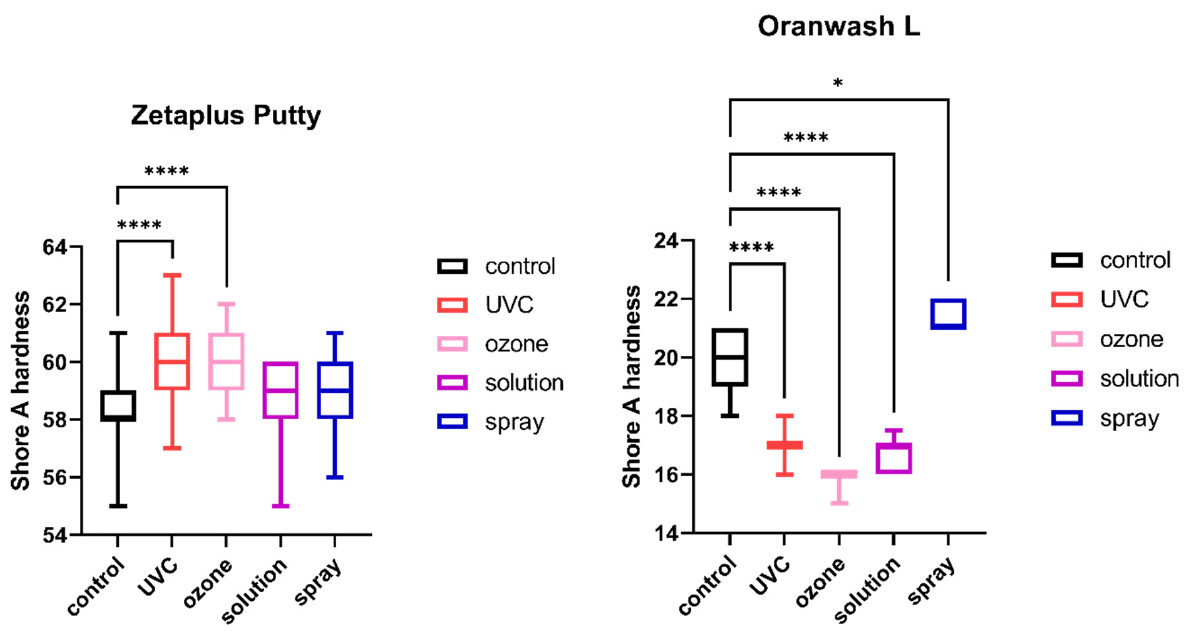
Figure 5. Shore A hardness of C-silicones (Zetaplus Putty and Oranwash L) after disinfection using various methods; * p < 0.05 and **** p < 0.0001 for the comparison between the study (disinfected) groups and the control (nondisinfected) group.